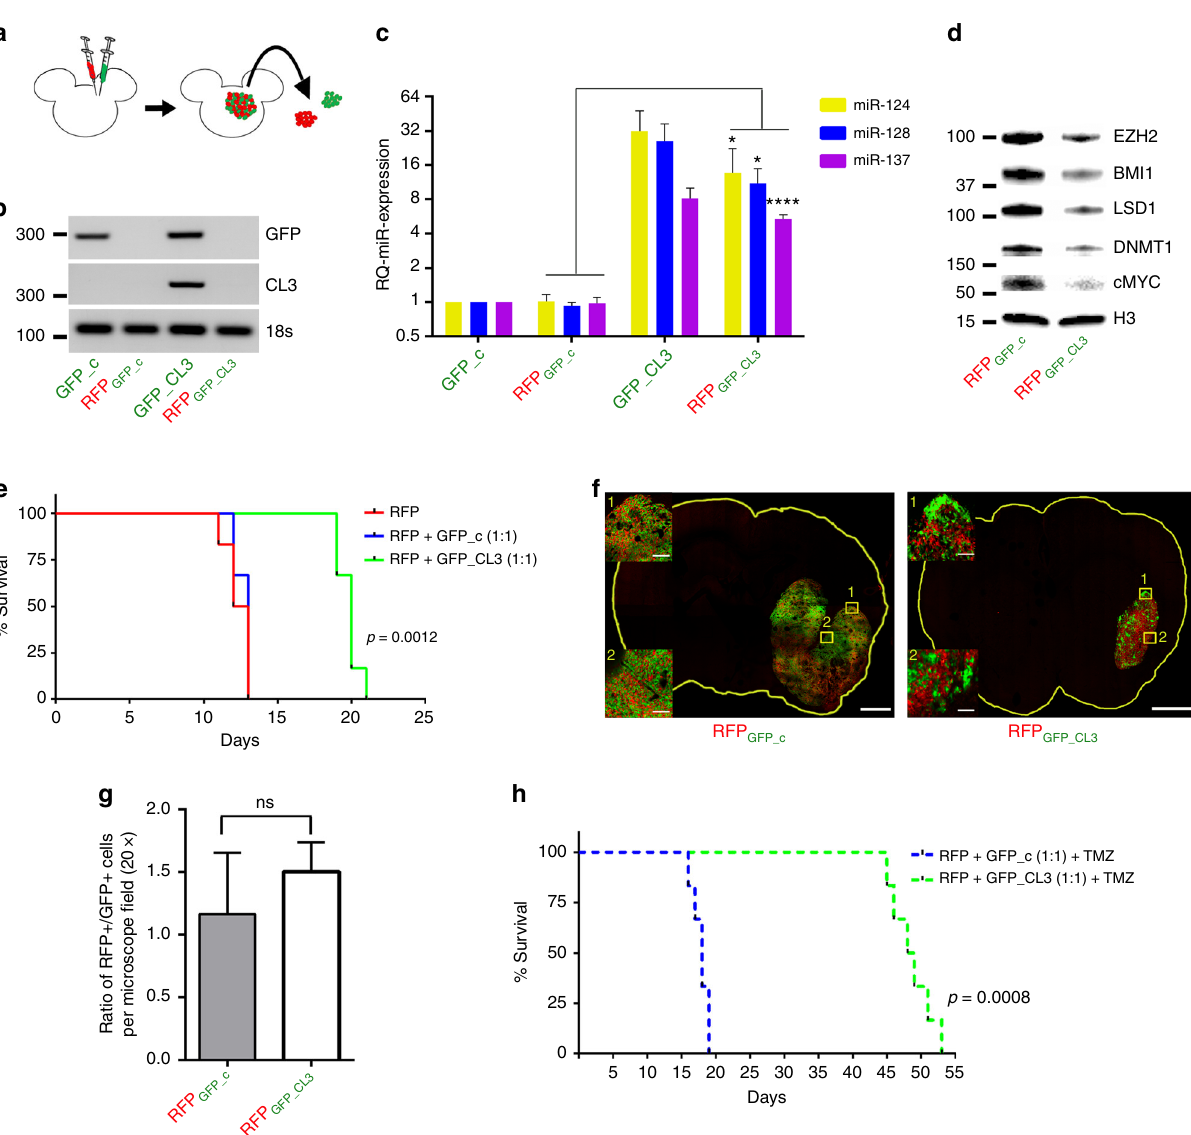
Fig. 6 In vivo evidence of microRNA transfer to bystander cells. a Scheme of experimental protocol. Red = RFP; Green = GFP. b Semiquantitative PCR of Cluster 3 and GFP transgene expression across the four different sorted cell populations. c Relative quanti fi cation of microRNA expression in G34 cells recovered from mixed intracranial brain tumors at time of mouse euthanasia (day 12). n = 3 animals/group. d Representative western blot analysis of protein amount in RFP control cells vs. RFP-Cl3. e Survival curve of athymic nu/nu mice (6 per group) intracranially implanted with RFP/GFP control vs. RFP/GFP-Cluster3 mixed in a 1:1 ratio. f Confocal microscopy image of one representative brain per group sacri fi ced at day 12, showing the two cell populations, at low magni fi cation and ×20 magni fi cation. Scale bars: 1 mm (whole slide); 100 µ m (inserts). g Ratio of RFP + /GFP + cells per ×20 microscopy fi eld (mean ± SD from nine random fi elds/tumor). h Survival curve of athymic mice (six per group) as described in e , with the addition of 20 mg/kg IP TMZ for 5 days starting at day 7 post implantation (Student ’ s t test, two tails). * p < 0.05; **** p <